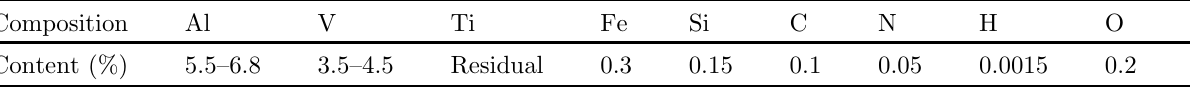
Fig. 6. The pro fi le size of square cone: (a) front view and (b) vertical view (unit: mm). Table 3. The chemical composition of TC4 titanium alloy.